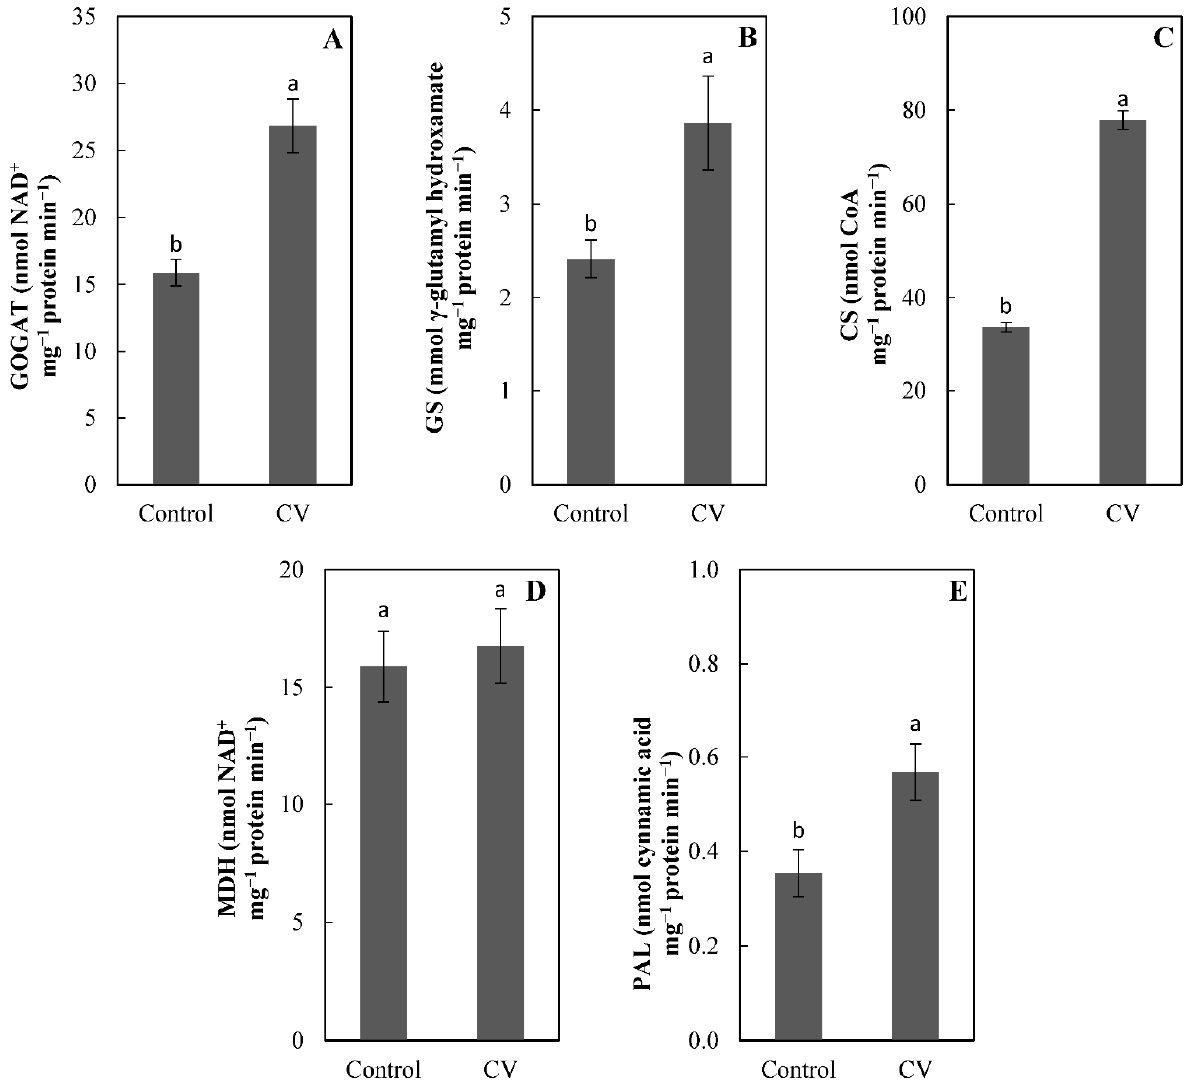
Figure 2. Glutamate synthase (GOGAT) activity ( A ), glutamine synthetase (GS) activity ( B ), citrate synthase (CS) activity ( C ), malate dehydrogenase (MDH) activity ( D ) and phenylalanine ammonia-lyase (PAL) activity ( E ) in leaves of lettuce seedlings. Error bars indicate standard deviation. The values are the means of data from five replications. Values followed by different letters are significantly different ( p < 0.05).